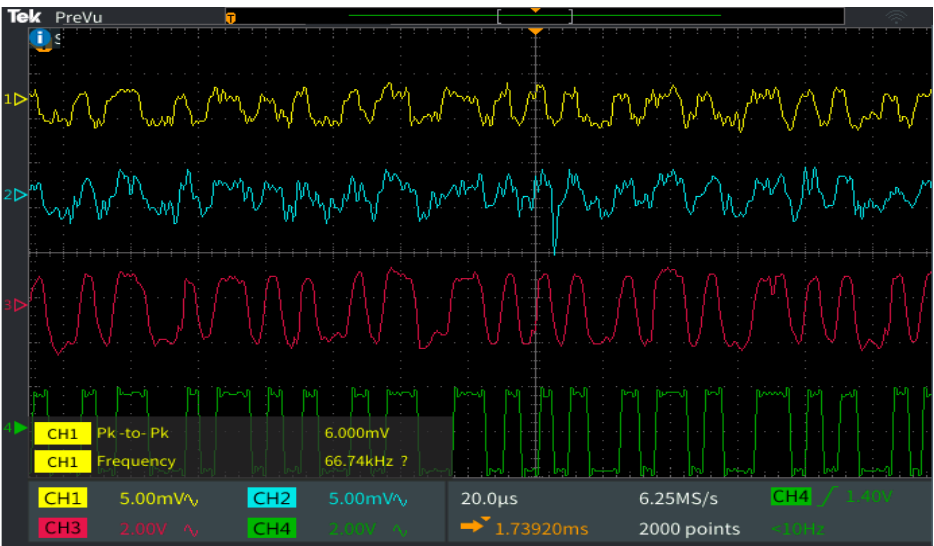
Figure 10. Oscilloscope screen showing the signal processing plan at the VLC receiver level: Channel 1 (yellow) shows the output of the optical receiver adjusted at 30 dB gain; Channel 2 (cyan) provides the output of the 1 kHz–200 kHz band-pass filter; Channel 3 (magenta) shows the amplified signal that will be fed into the Schmitt trigger circuit; Channel 4 (green) displays the final data signal that will be provided to the microcontroller for the data extraction process.